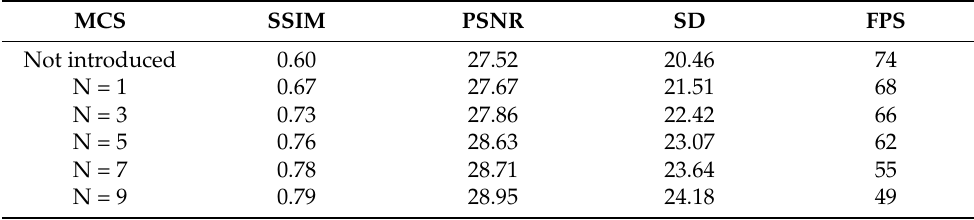
Table 7. Introducing a comparison of Monte Carlo search times.